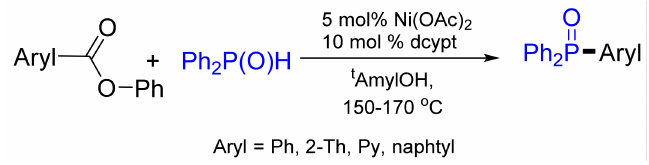
Figure 22. Decarbonylative coupling of esters with phosphane oxide.